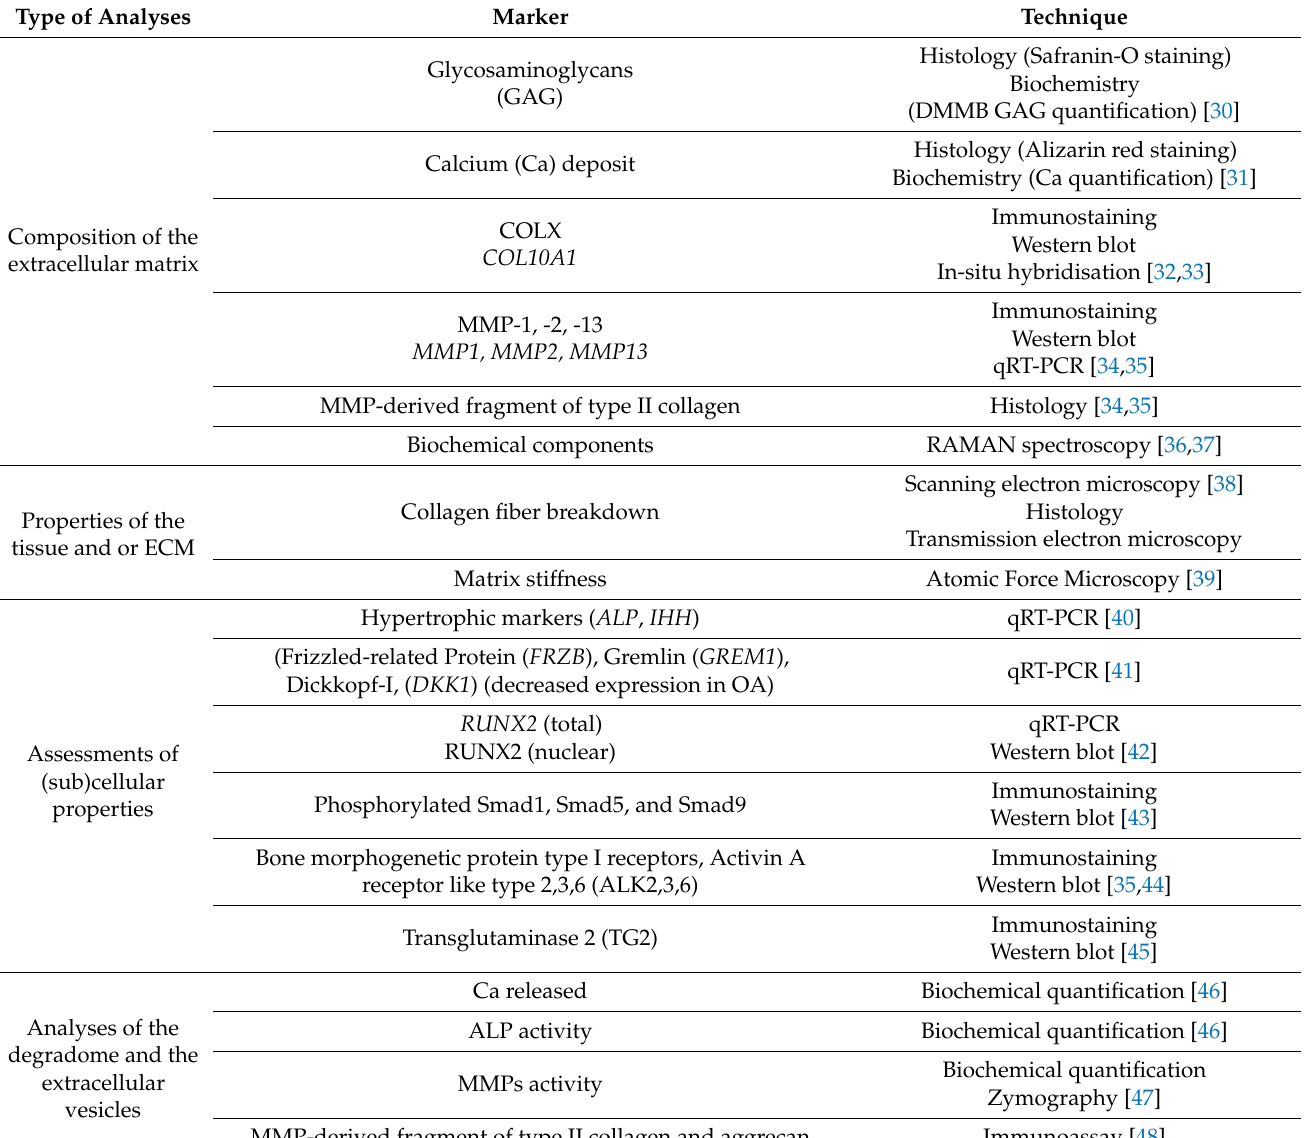
Table 1. Analyses to assess the extent of chondrocyte hypertrophy and cartilage mineralization.